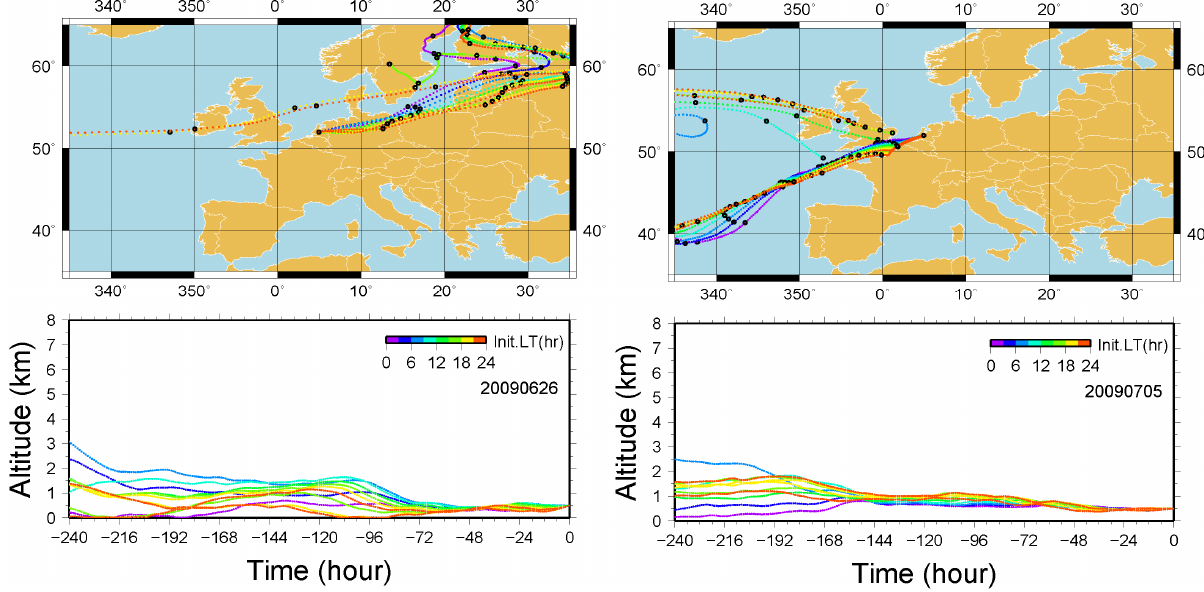
VMRs at Cabauw 2